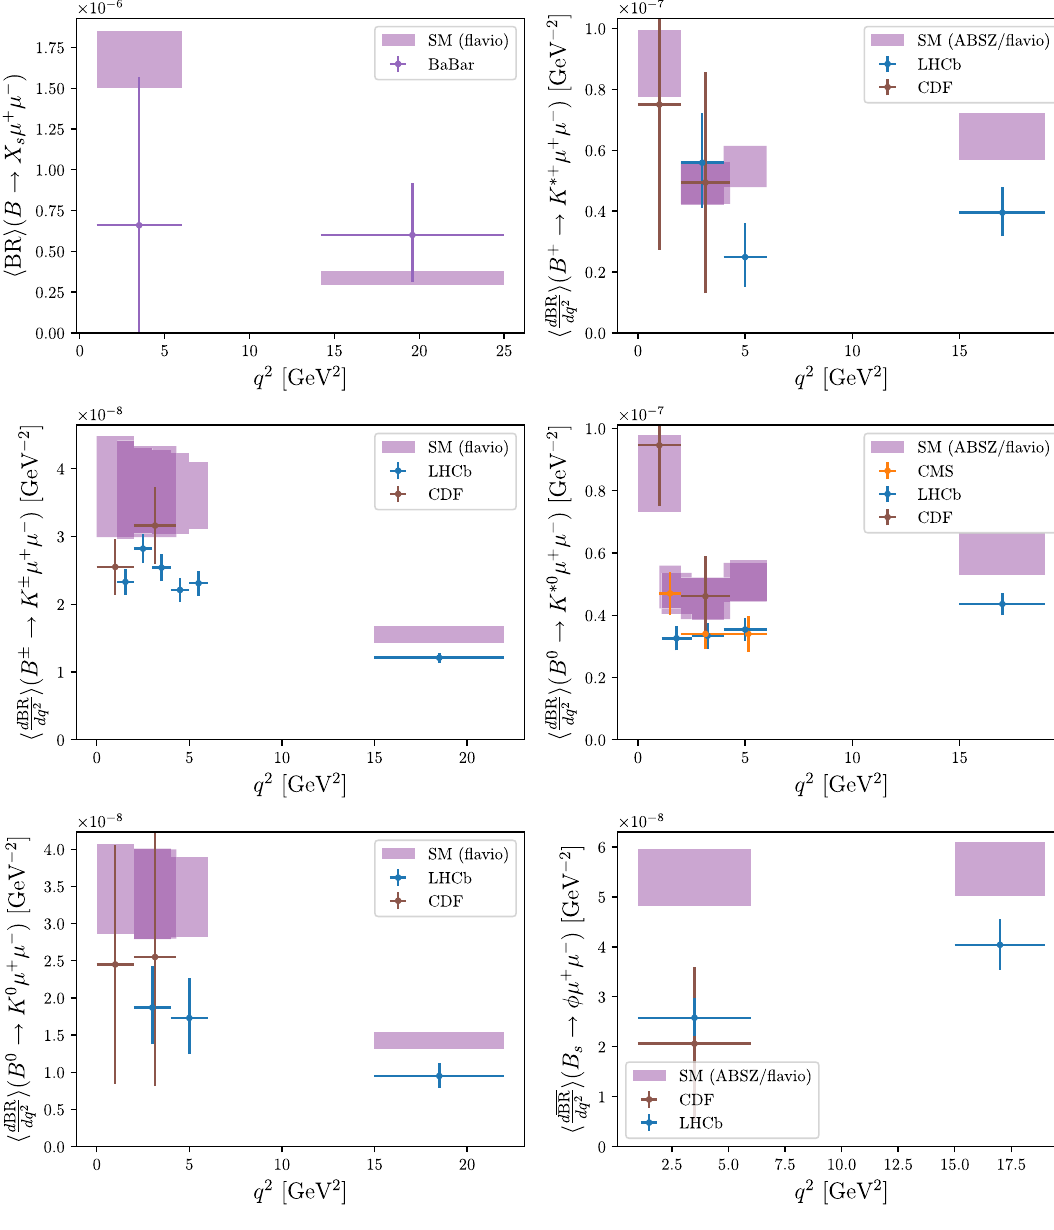
ables. Assuming that the new physics affects only b → s μμ but not b → see transitions, we confirm that the latest B → K ∗ μ + μ − data shows astonishing compatibility with the LHCb measurement of the LFU ratio R K . Future mea- surements of LFU observables that show significant devia- tions from SM predictions could not be explained by under- estimated hadronic contributions but would be clear evidence for a new physics